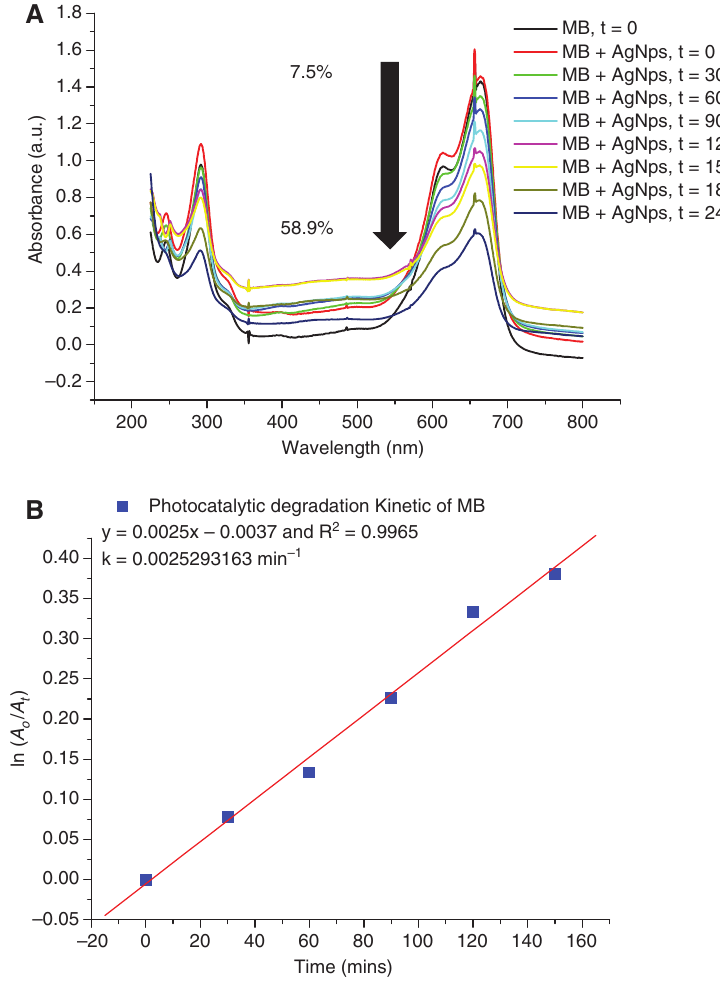
/ A ) v/s time kinetic plot using silver nanoparticles (AgNps) as a 0 t